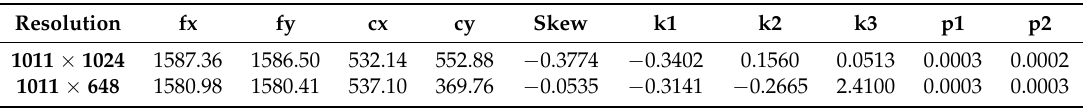
Table 2. Internal camera parameters and distortion coefficients of the Rikola hyperspectral camera for full and half image